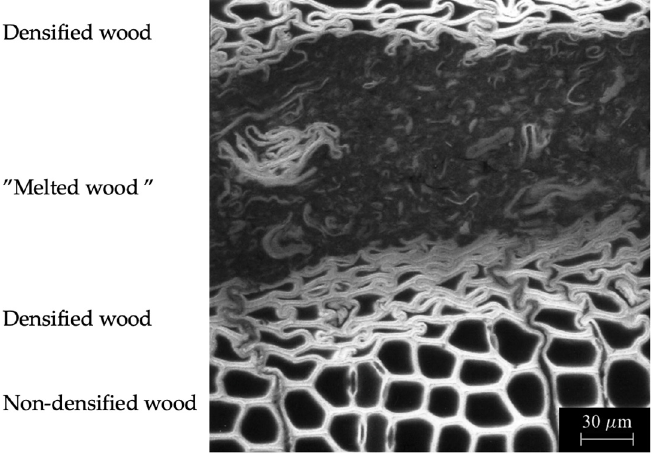
Figure 5. Micrograph of a bond-line between two pieces of Norway spruce joined by circular friction welding [24].